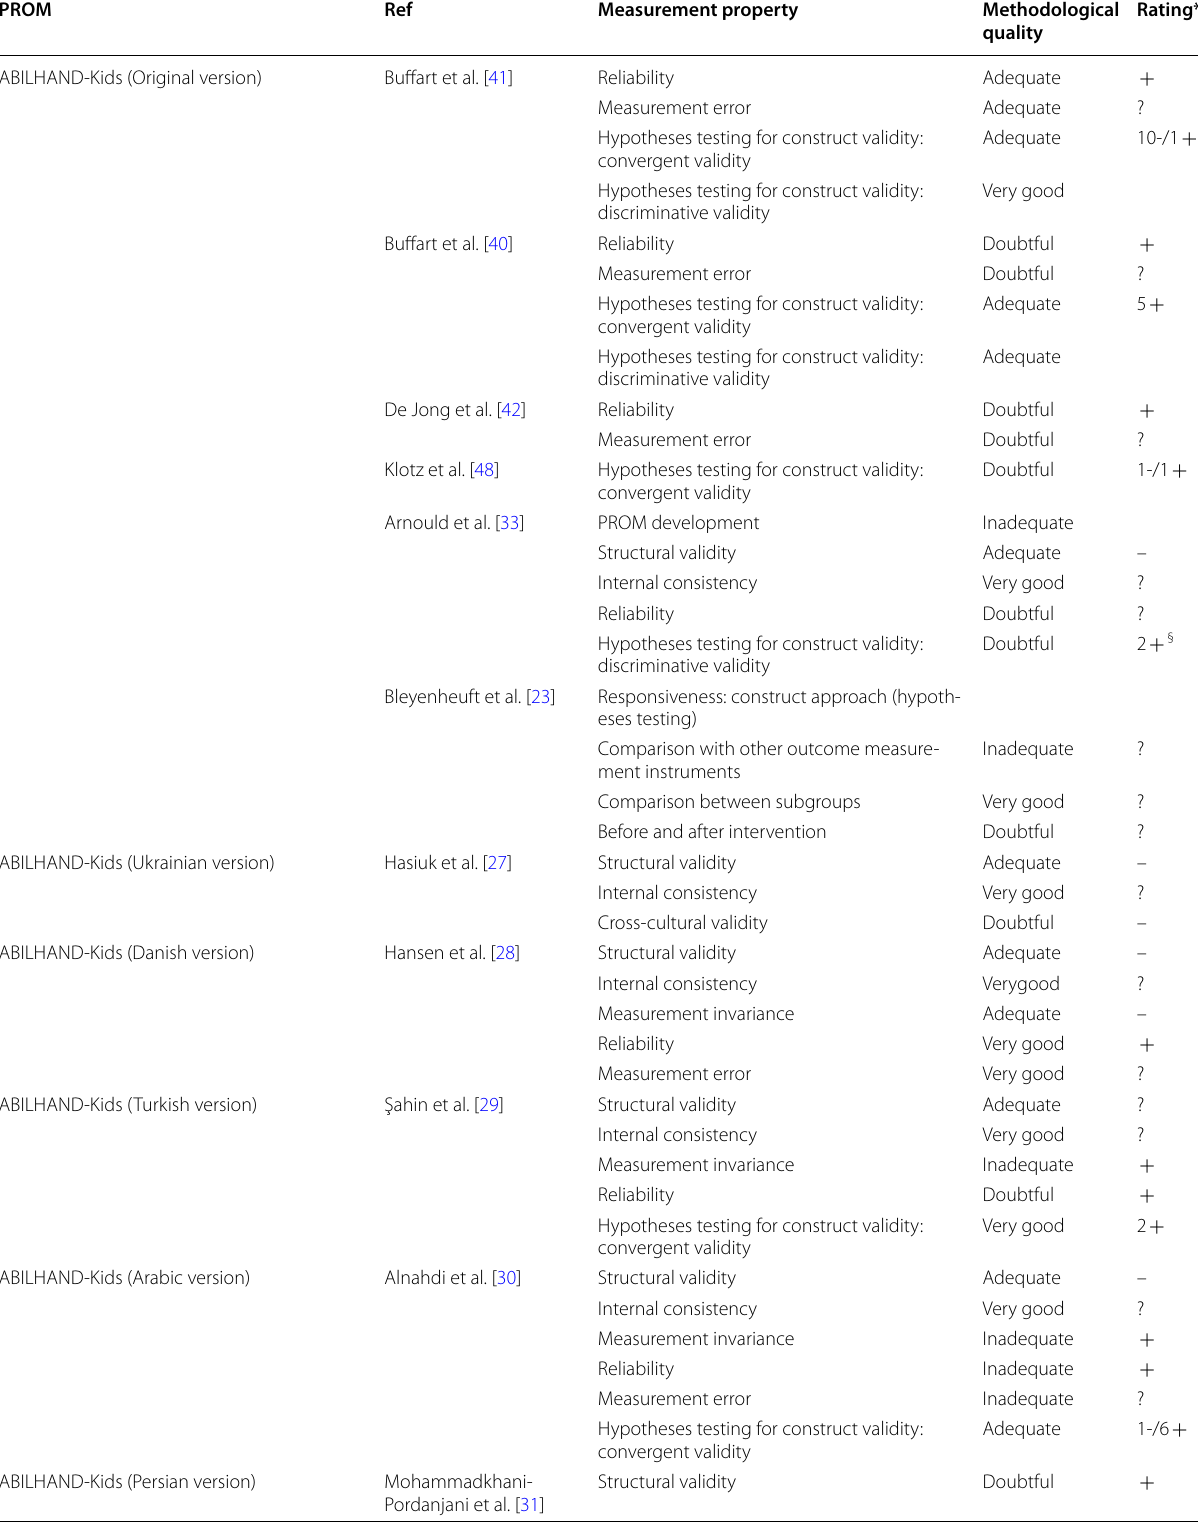
Table 3 Methodological quality and ratings of measurement properties of the included